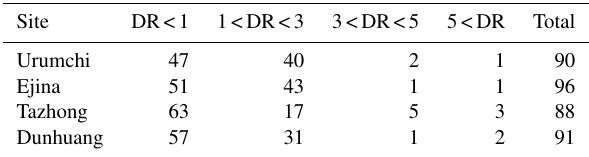
Table 7. DR distribution of specific